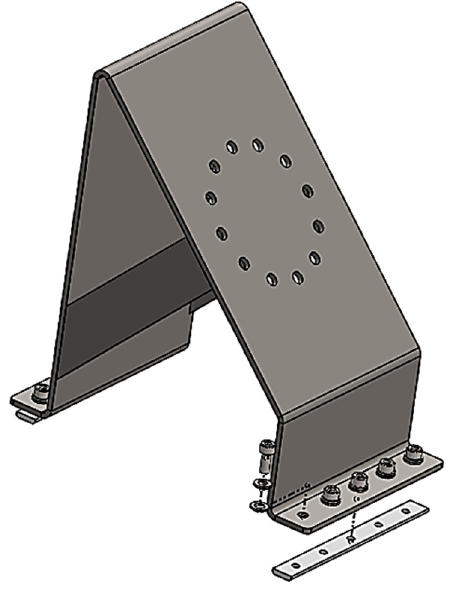
Figure 25. Robotic arm linking assembly.